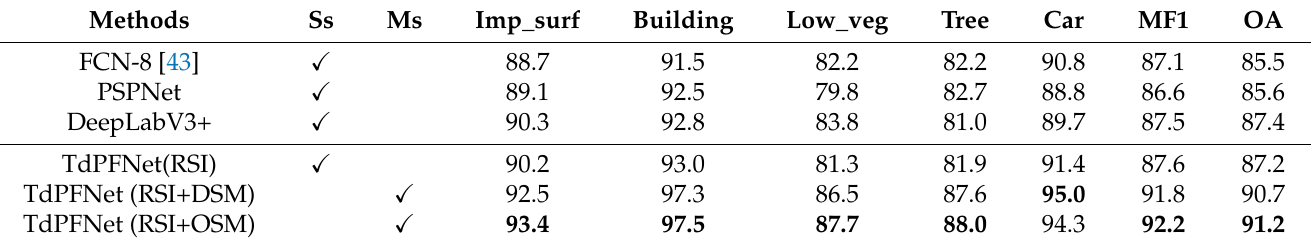
Table 2. Detailed performance comparisons with single-source methods on Potsdam test set. The number in bold is the maximum value. All data are shown in percentage. Ss: Single-source. Ms: